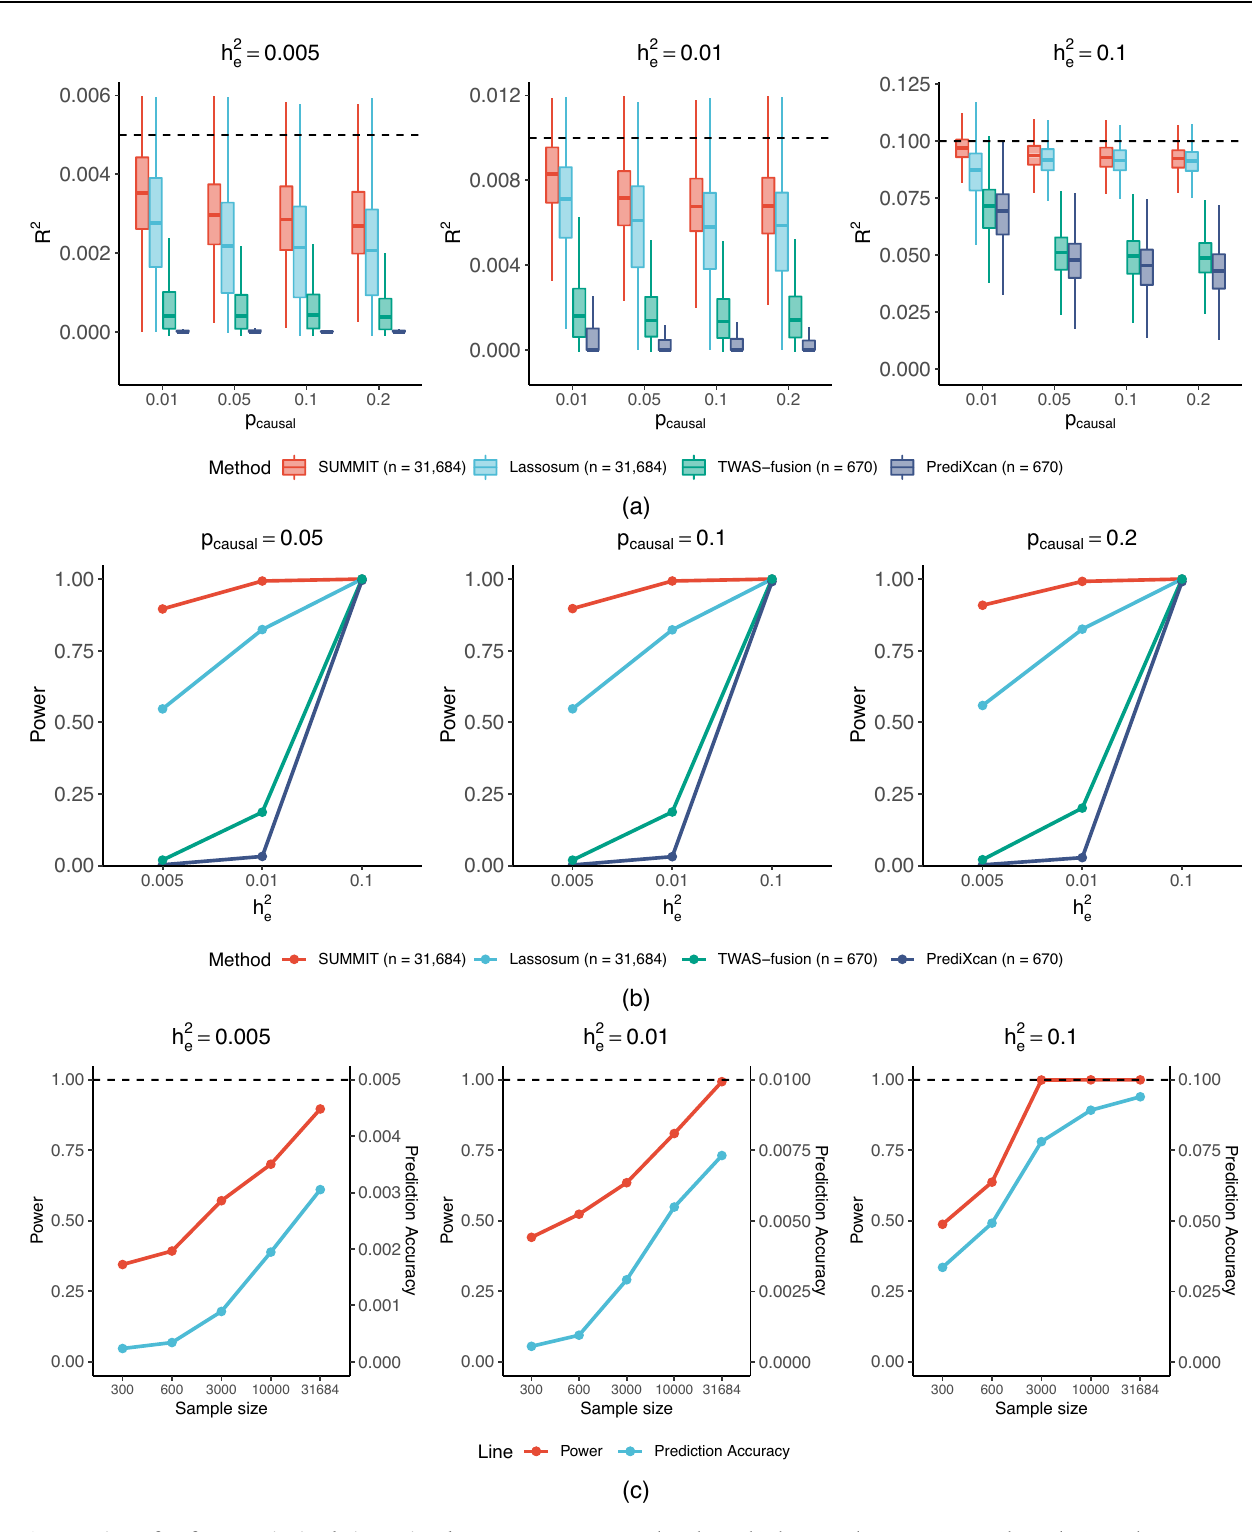
Fig.2|Comparisonofperformanceinsimulationsusingthe CHURC1 geneasan example. Plots of imputation R 2 ( a ) and subsequent power ( b ) in test samples by SUMMIT, Lassosum, TWAS-fusion, and PrediXcan, with varying expression herit- ability h 2 e and proportion of true causal SNPs p causal . The results were based on 1000 simulation replicates. In sub fi gure( a ), the box limits represent the lowerand upperquartiles,thecentralline represents themedian, and the whiskersrepresent all samples lying within 1.5 times the interquartile range (IQR). Sub fi gure ( c )